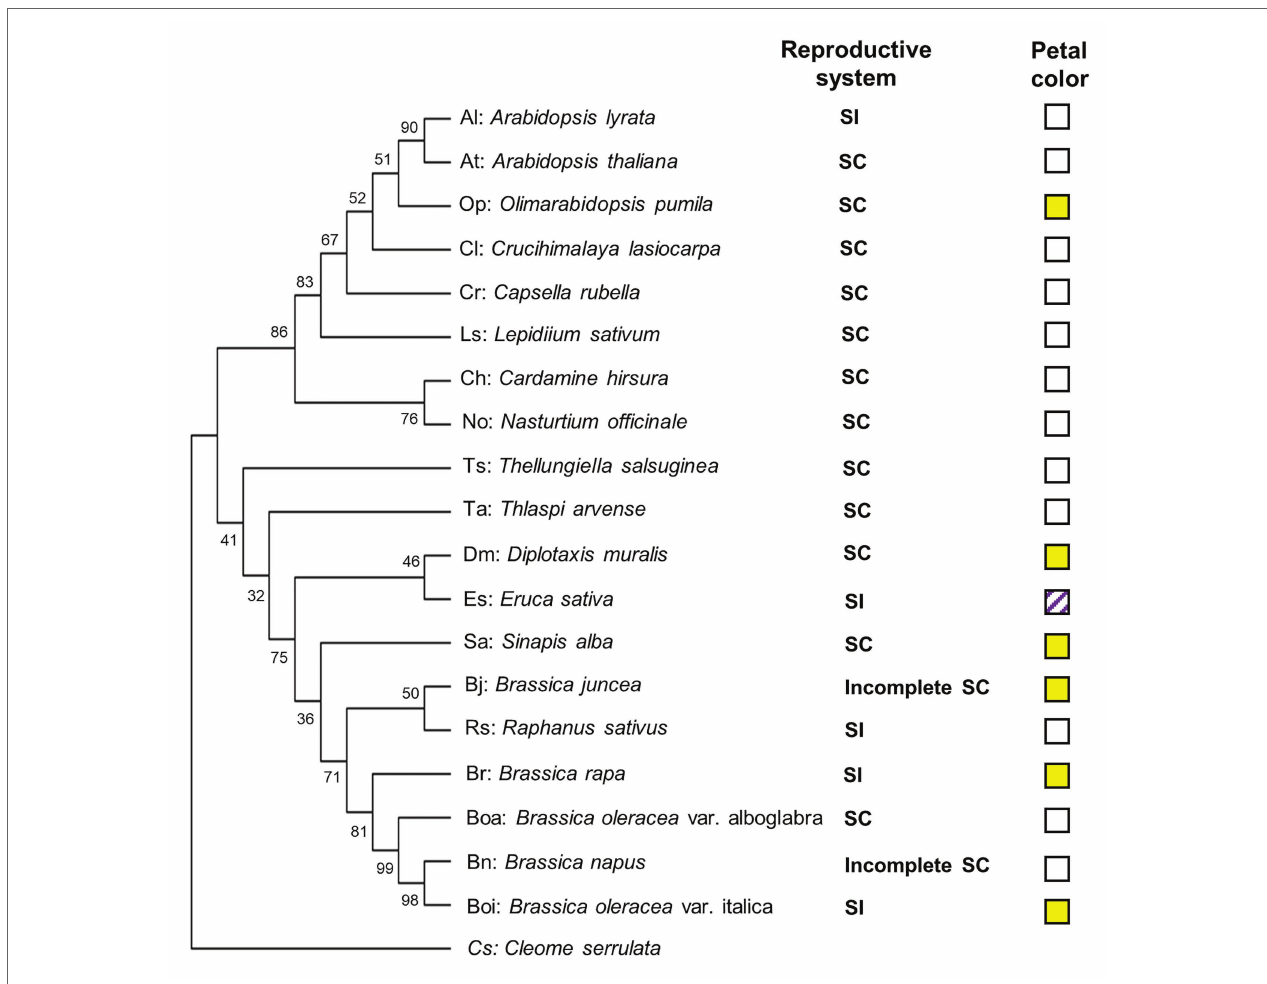
FIGURE 1 | Phylogenetic diagram of the relationships among selected Brassicaceae genotypes. The phylogenetic tree was constructed by MEGA X (Kumar et al., 2018) using the sequence of the internal transcribed spacer (ITS) gene of each genotype. Cleome serrulata was set as outgroup. The maximum likelihood (ML) method was used with the following parameters: General time reversible model, complete deletion and bootstrap (1,000 replicates). Values on the branches indicate bootstrap support in percentages. SC indicates self-compatible. SI indicates self-incompatible, incomplete SC indicates incomplete self-compatible. White square indicates white flower color, yellow square indicates yellow flower color, and white squares with purple stripes indicate white flower with purple